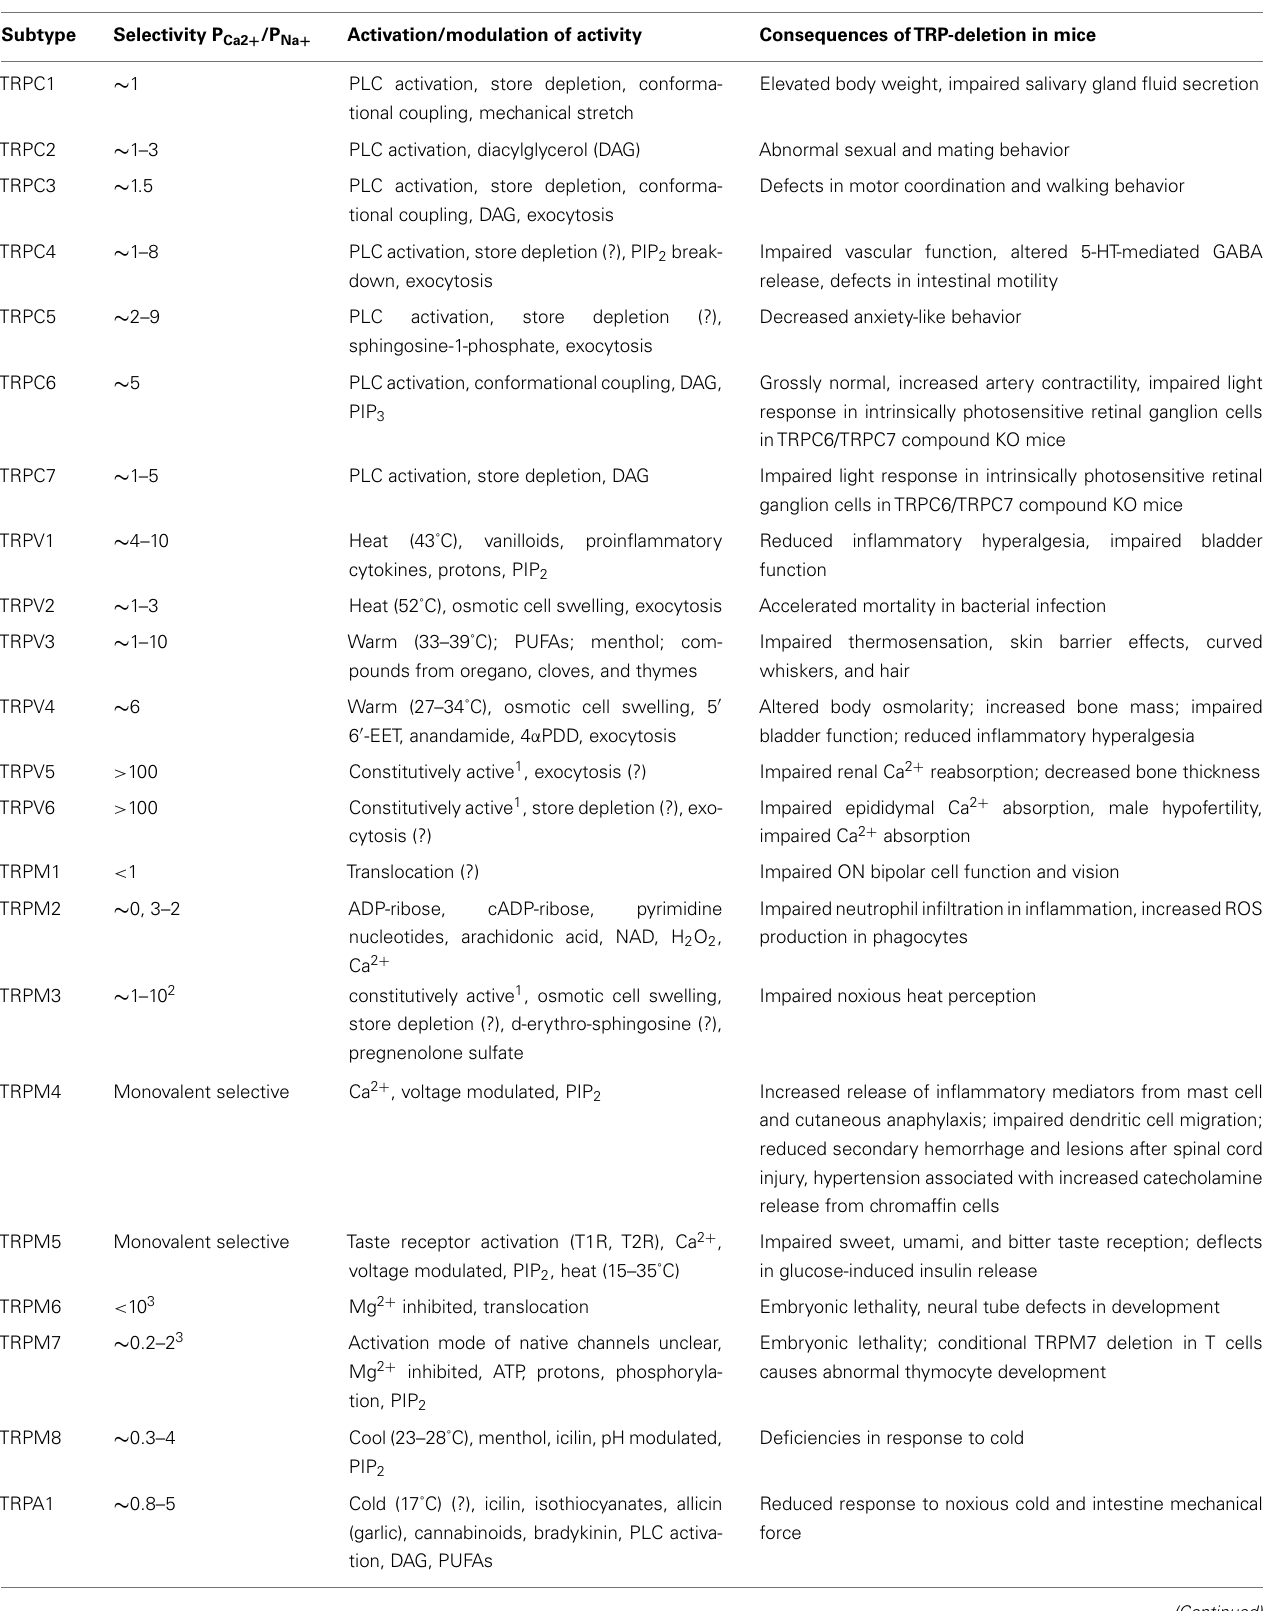
Table 1 | Properties of channels formed by mammalianTRP